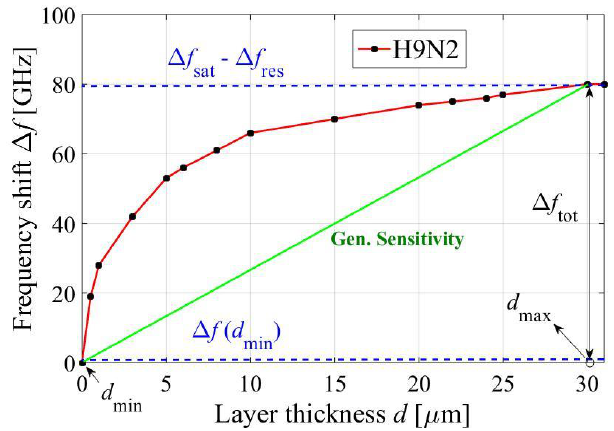
Figure 9. Graphical review of the introduced sensitivity parameters.